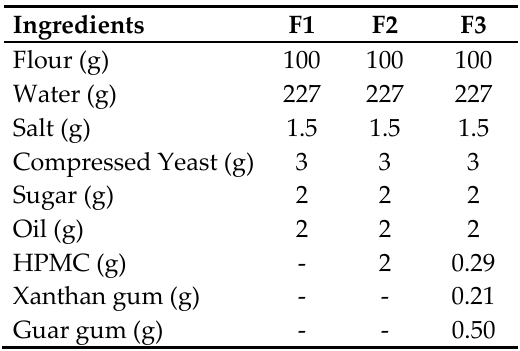
Table 1. Gluten-free bread recipes.